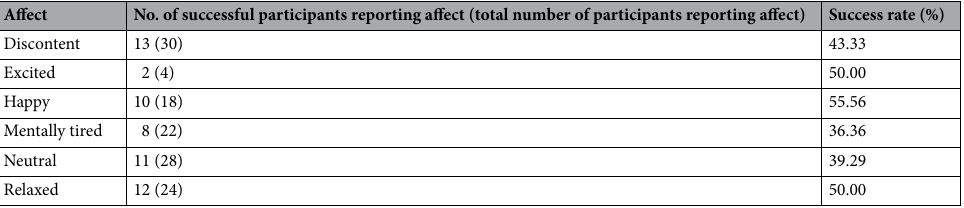
Table 5. Success rates of affect induced by mental strategies.